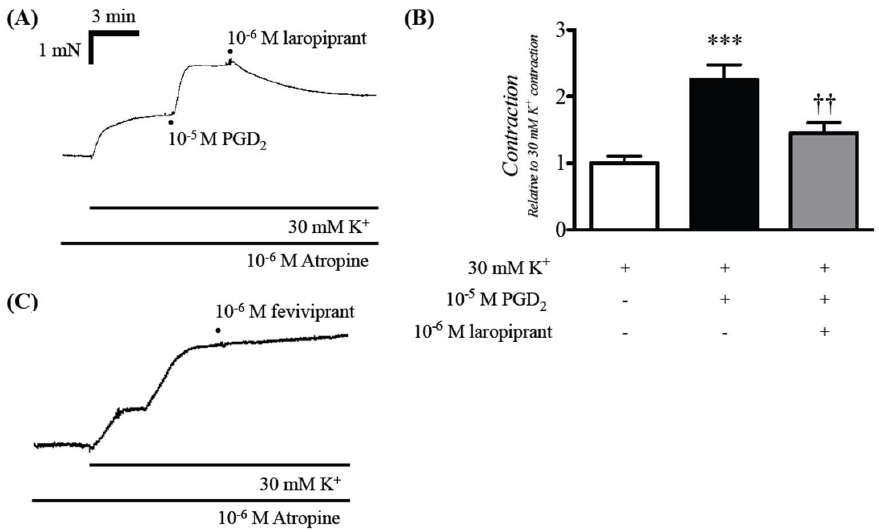
Figure 3. Effect of laropiprant (a selective DP 1 receptor antagonist) on the augmented contraction induced by prostaglandin D 2 (PGD 2 ) in bronchial smooth muscles (BSMs) isolated from mice. After the BSM contraction induced by PGD 2 reached to plateau, 10 −6 M laropiprant was applied. Representative traces of changes in the active force are shown in ( A ), and the data are summarized in ( B ). Results are presented as mean ± SEM from 5 animals. *** p < 0.001 versus 30 mM K + only group and †† p < 0.01 versus 30 mM K + + 10 −5 M PGD 2 group by one-way ANOVA with post hoc Bonferroni’s multiple comparison. Note that fevipiprant (10 −6 M, a selective DP 2 receptor antagonist) had no effect on the PGD 2 -induced augmentation of contraction ( C ).